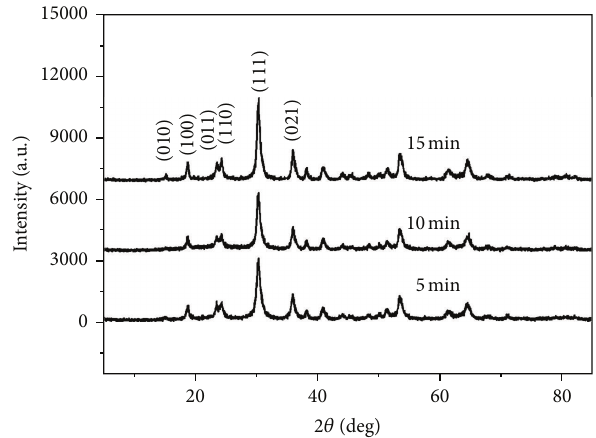
Figure 2: XRD patterns of ZnWO 4 formed for a different reaction time at 180 ∘ C.